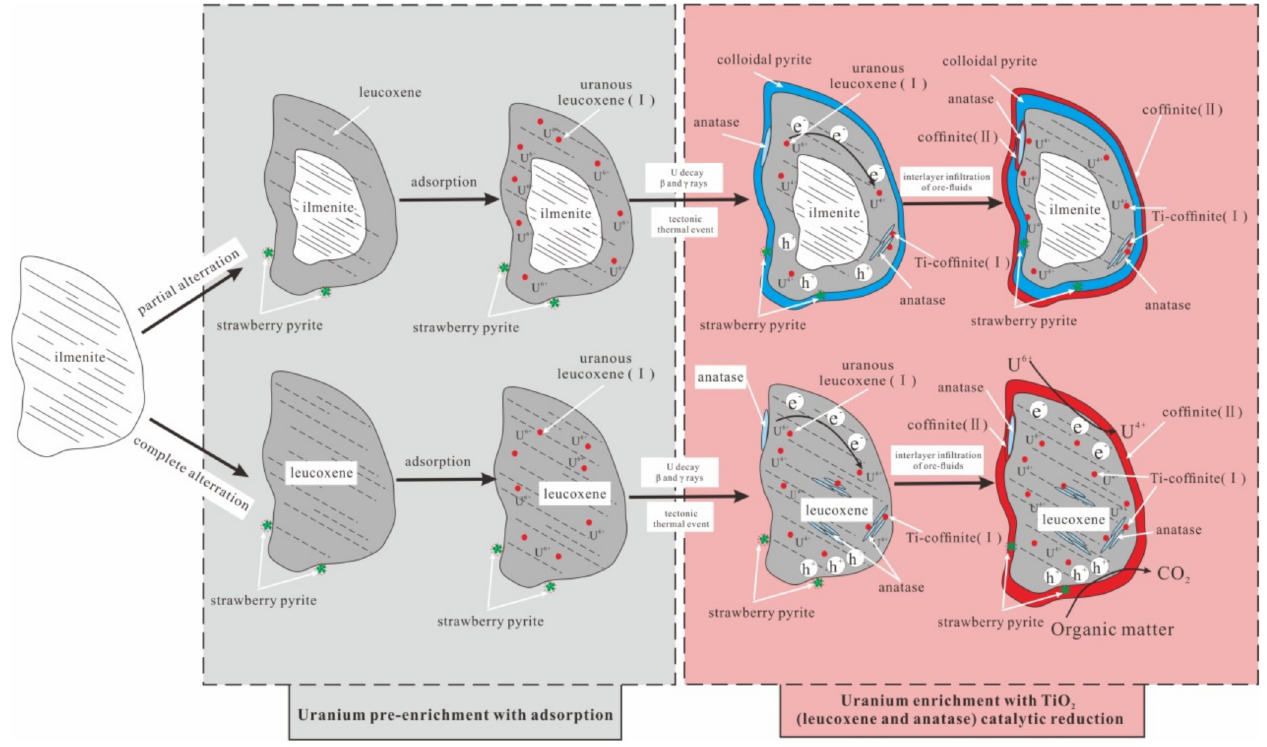
Figure 8. U enrichment mechanism and alteration processes of ilmenite in sandstone-hosted U deposits in the northern Ordos